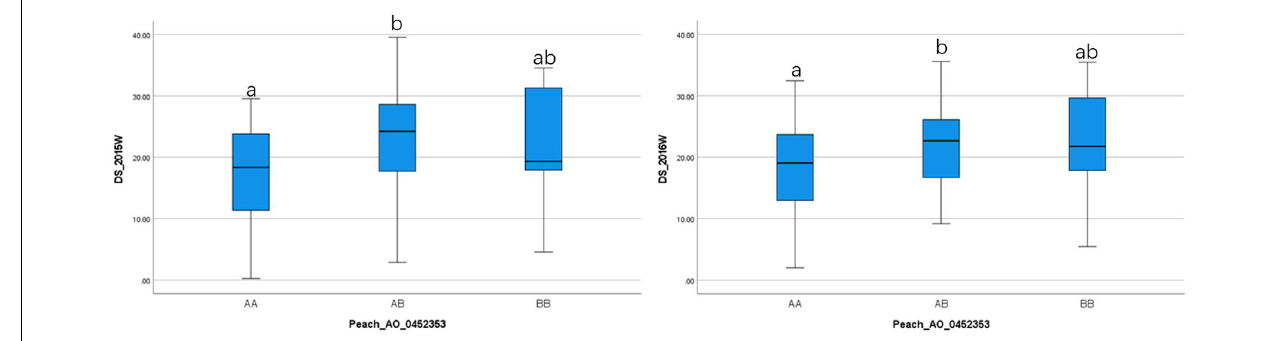
FIGURE 3 | Comparison of the phenotypic performance for difference genotypes of Peach_AO_0462363 in two different seasons (2015 and 2016) in wounded (W) fruits.